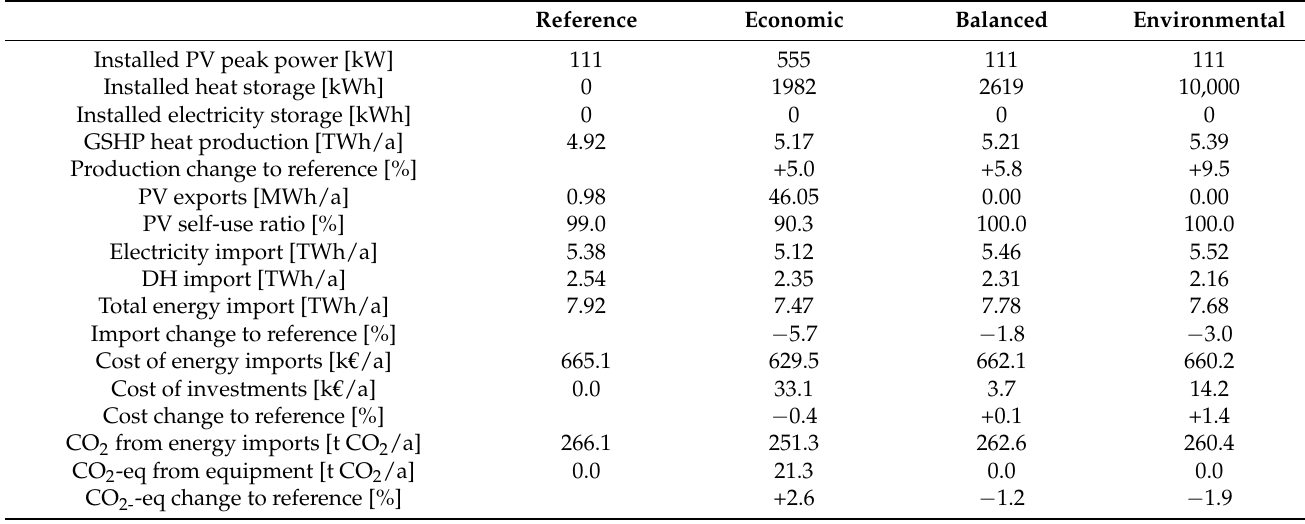
Table 6. Energy system optimization results and parameters for the three optimization objectives simulated in Calliope, compared to the reference